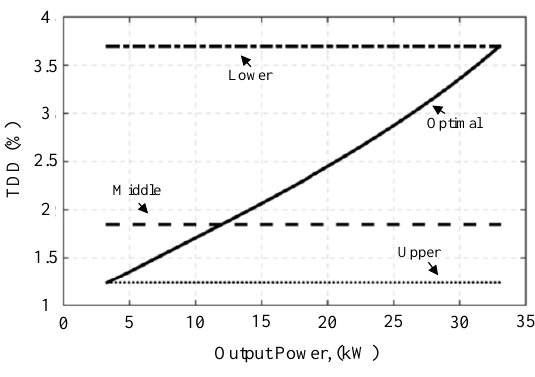
Figure 6. TDD versus output power for different switching frequencies.